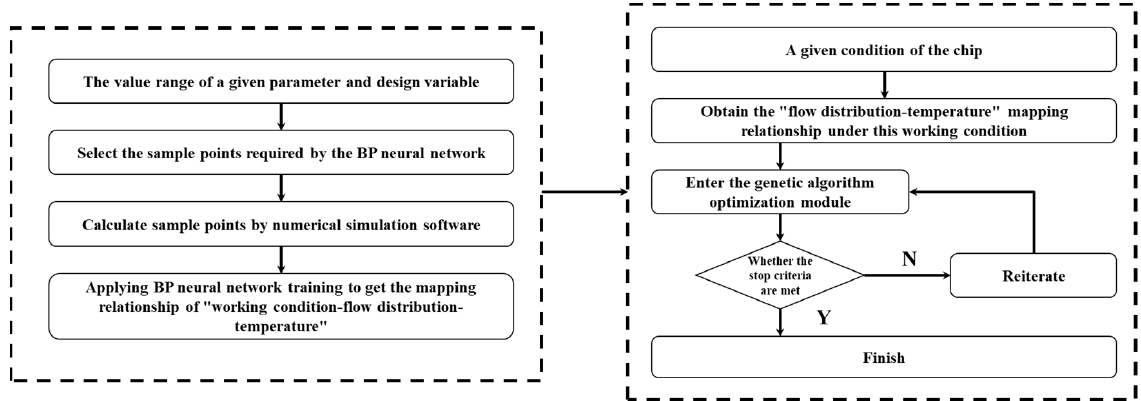
Figure 5. Flowchart of the optimization scheme.